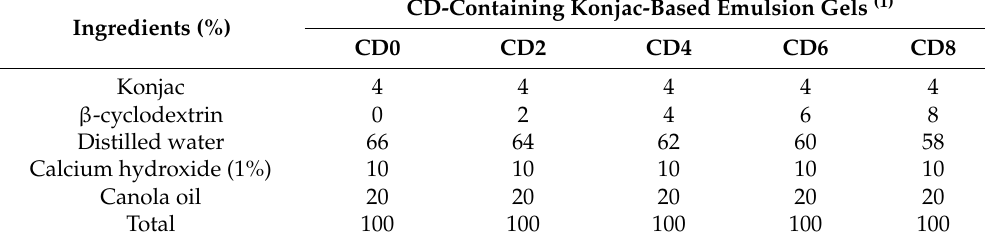
Table 3. The formulation of emulsion